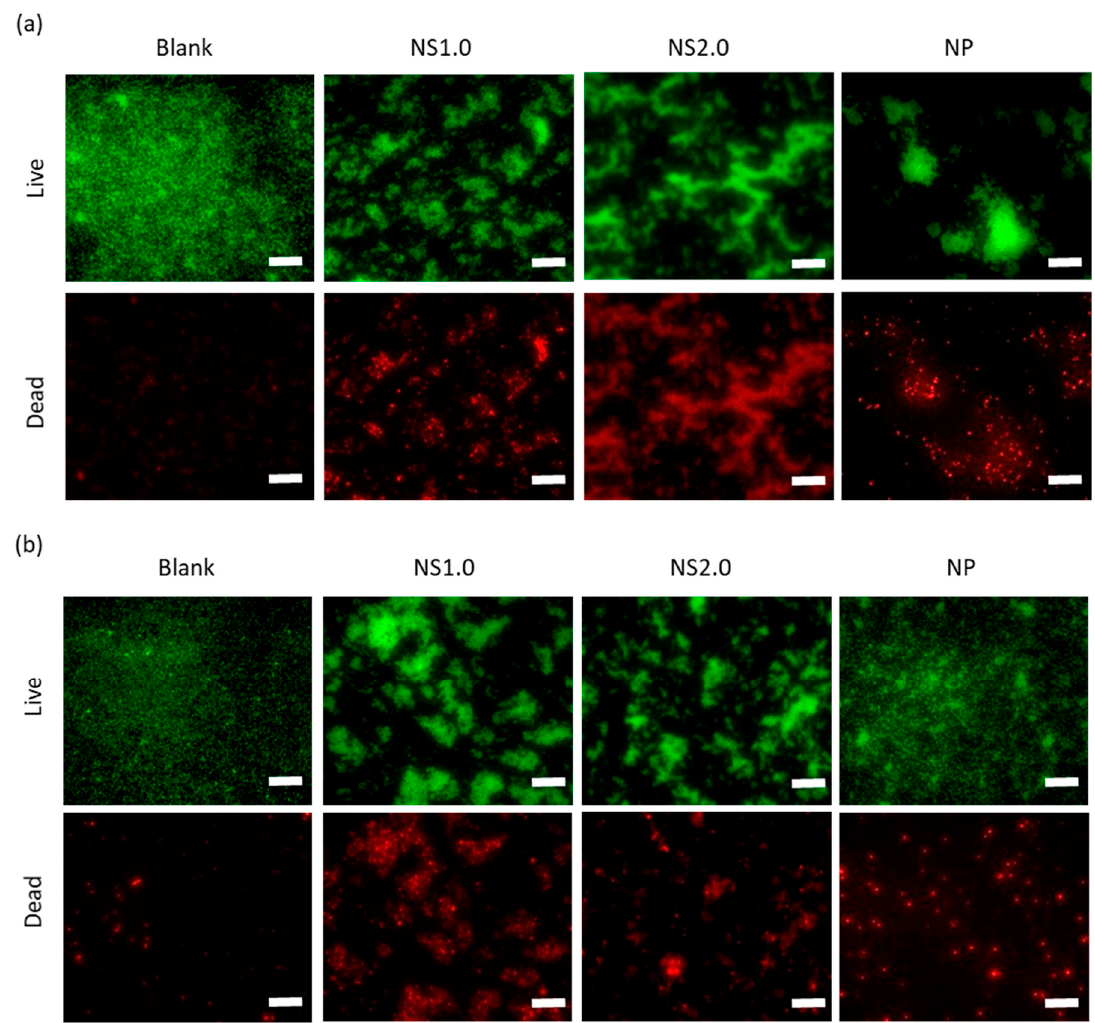
Figure 6. Live/dead staining images of S. mutans under the presence ( a ) and absence ( b ) of UV irradiation conditions. Green fluorescence shows live cells stained with SYTO9 (upper panel), while red fluorescence shows dead cells stained with propidium iodide (PI) (lower panel). Scale bar: 250 μ m.